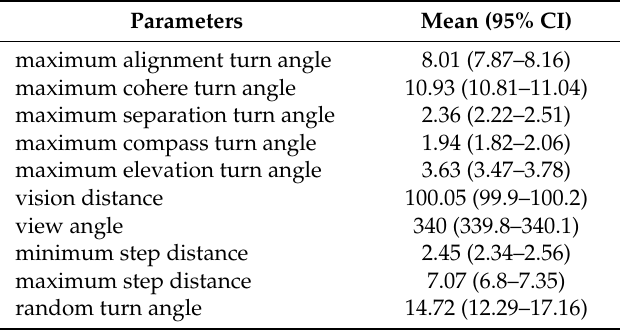
Table 4. Average of flocking and navigation parameters as calculated from the model.